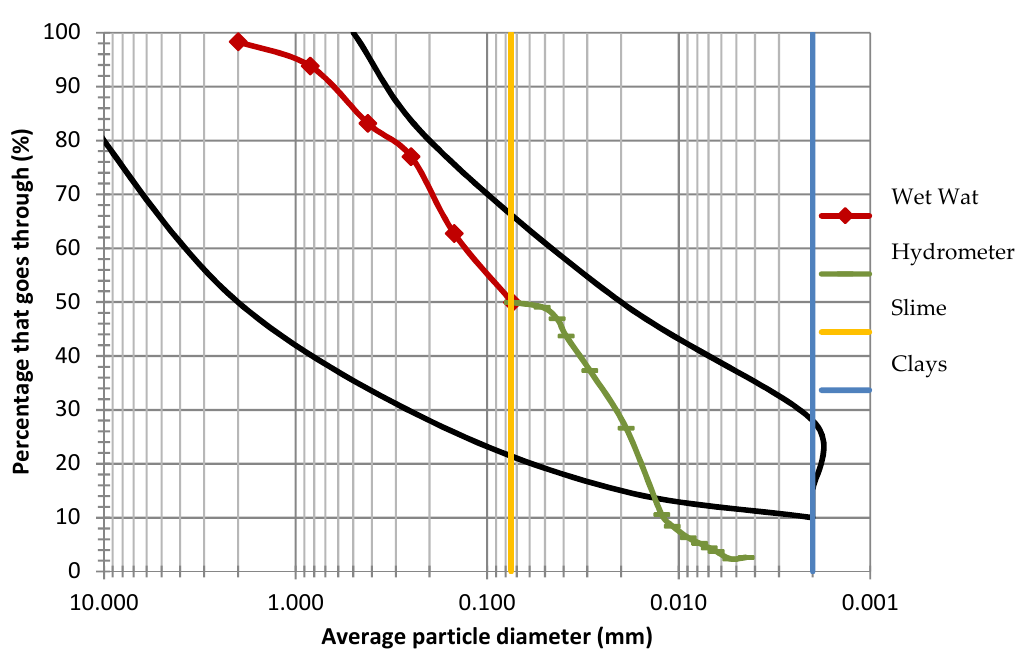
Figure 5. Granulometric curve of the Toluca and Cuernavaca excavation material mixture.